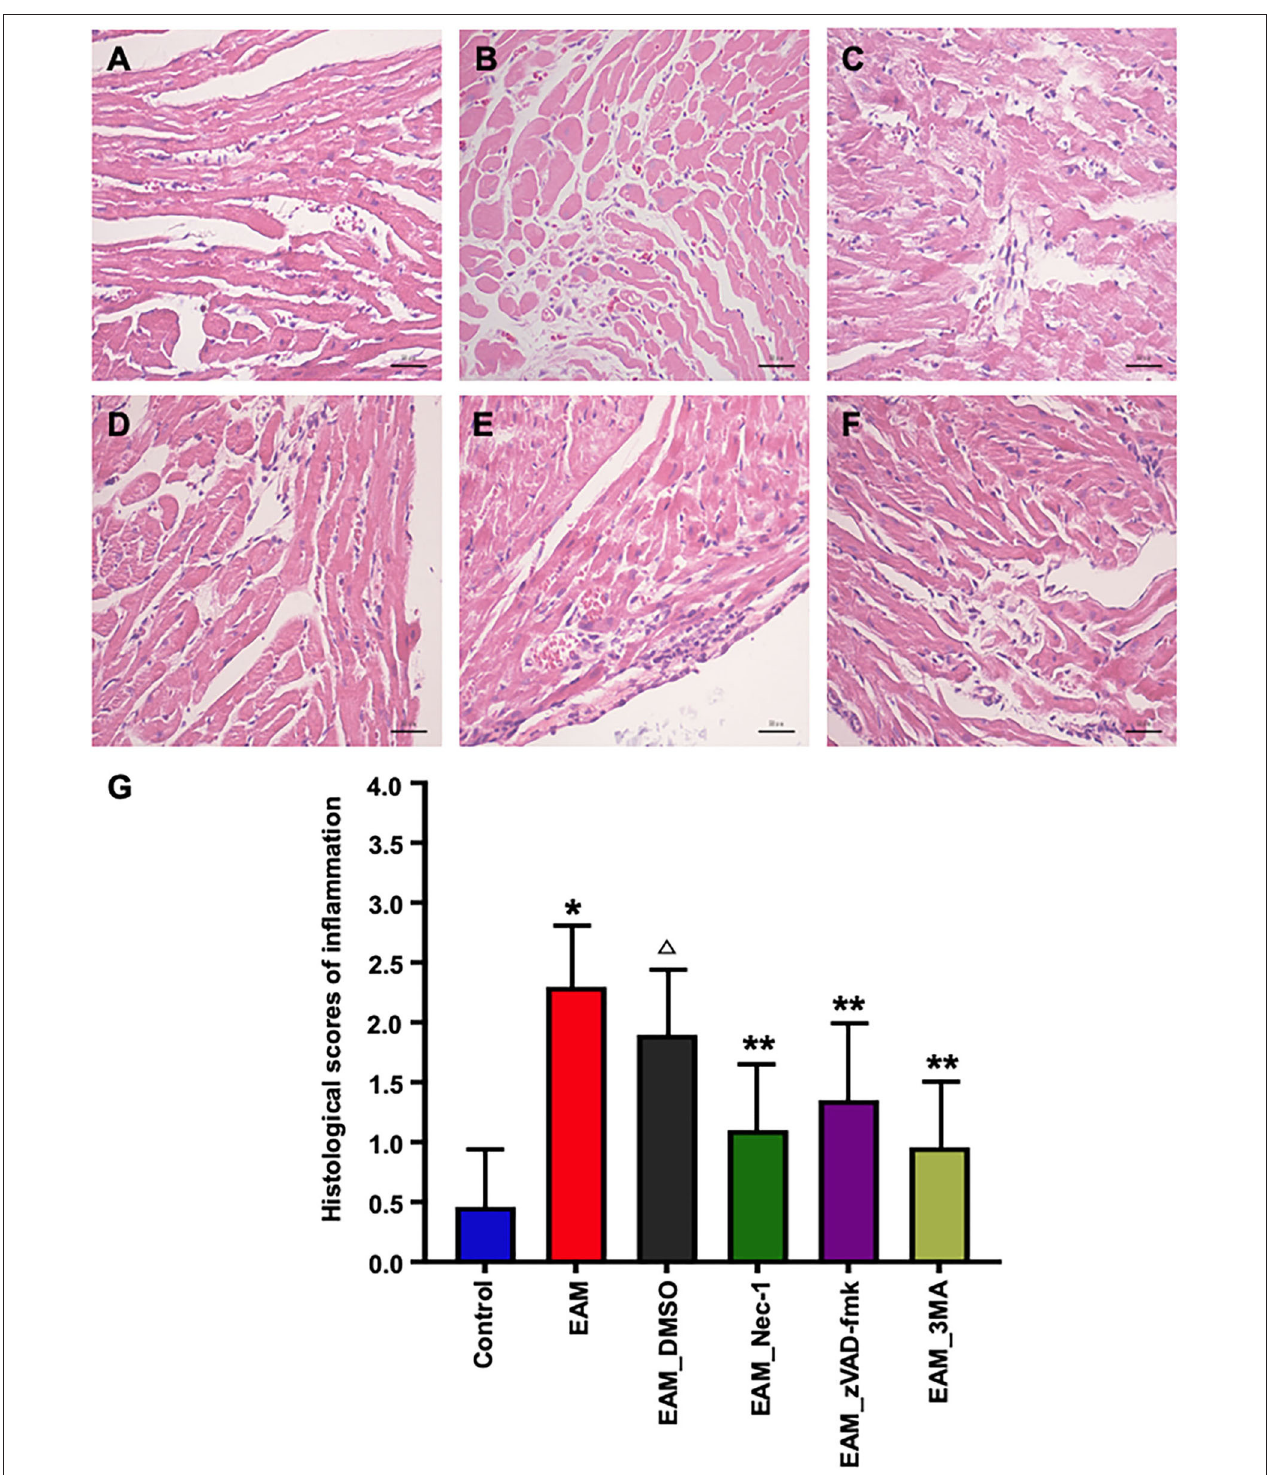
FIGURE 8 | Pathological evaluations of myocardial tissues of various groups by HE staining. (A) In the heart of control group rat, there was no inflammatory infiltrate. (B,C) HE staining showed dense inflammatory infiltrates in the EAM (B) group (3W) and IMM + DMSO group (C) . Treating rat with Nec-1, zVAD-fmk, and 3-MA on day 21 attenuated inflammatory infiltrates. Only little scattered inflammatory infiltrates were detected in the EAM + Nec-1 group (D) . (G) Quantification of cellular inflammatory infiltration in (A–F) . All data are presented as mean ± SEM. A Student’s t -test was performed for the control group and IMM group, one-way analysis of variance (ANOVA) followed by the LSD test. * p < 0.05 vs. control group, ** p < 0.01 vs. EAM + DMSO group, p < 0.05 vs. EAM. 1 Compared with EAM group, the EAM_DMSO group has no significance.